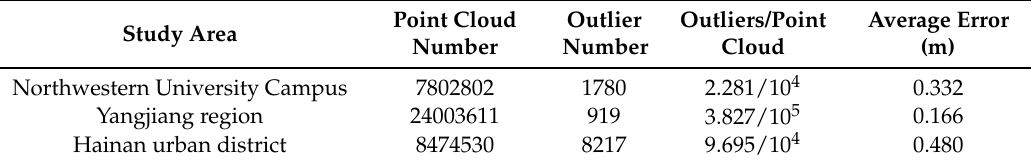
Table 6. Evaluation of